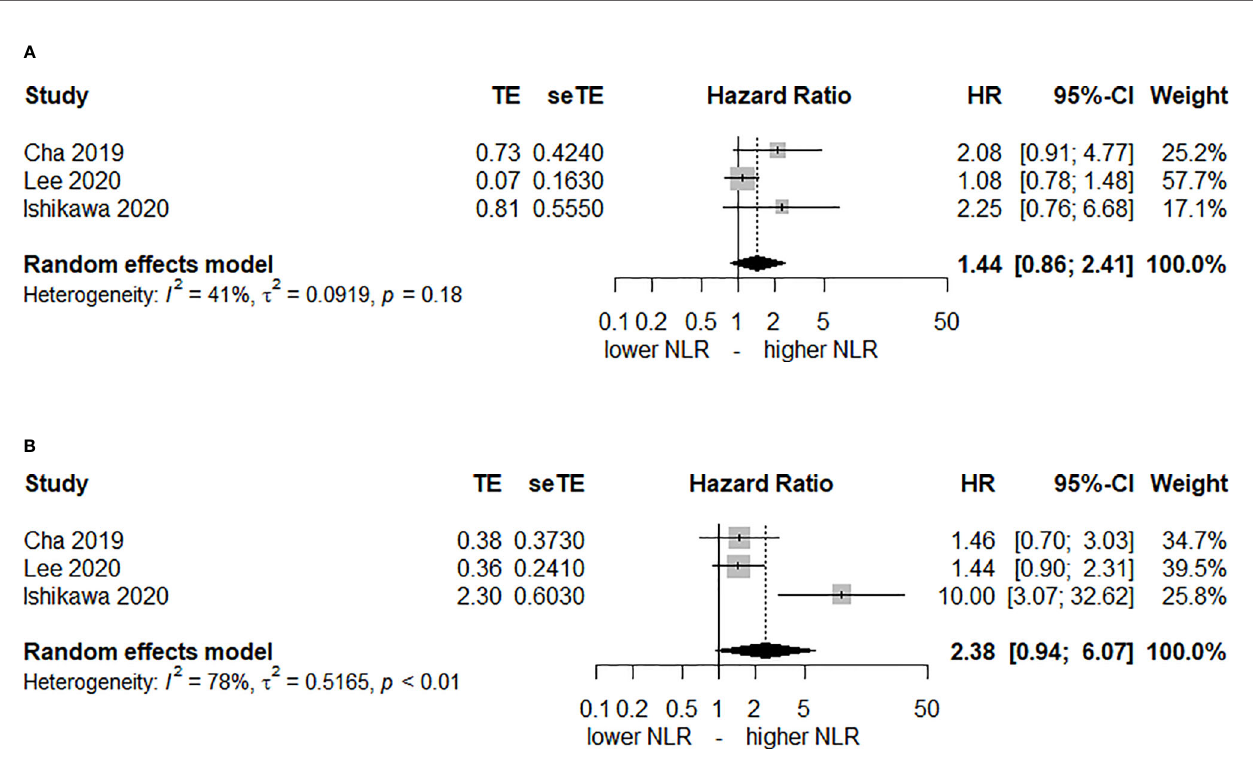
FIGURE 3 | Forest plot of hazard ratios (HR) for an elevated neutrophil-lymphocyte ratio (NLR) after chemoradiotherapy. (A) disease-free-survival and (B) overall